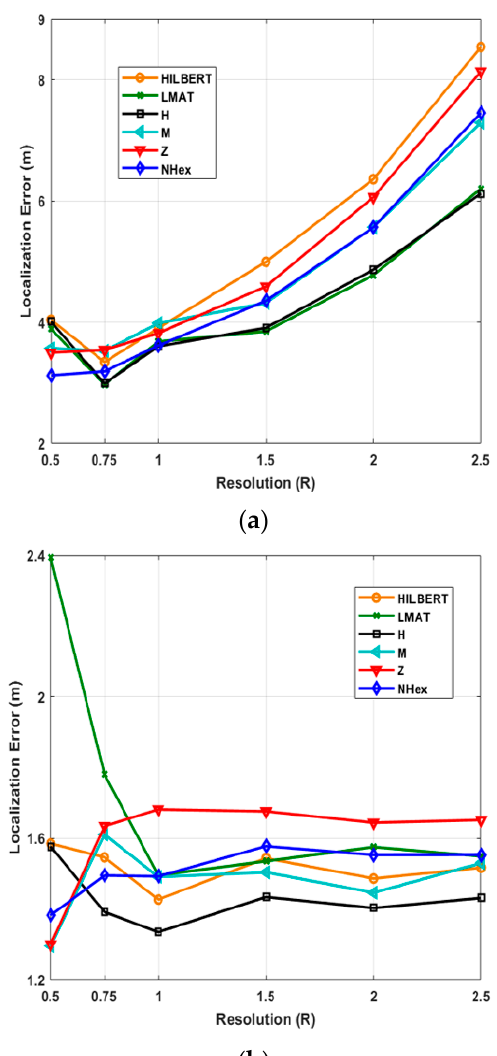
Figure 12. Average localization errors of models by resolution in ( a ) WCL, and ( b ) APT.